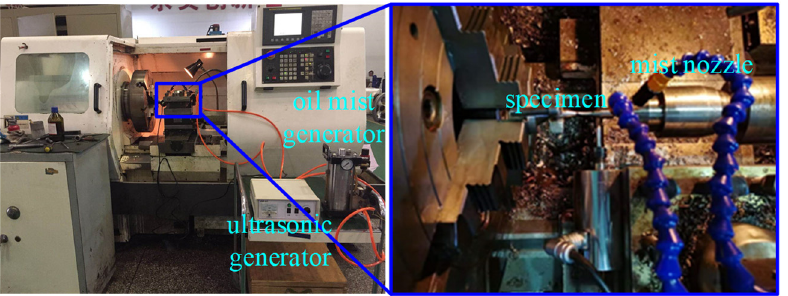
Figure 2. Ultrasonic impact process.